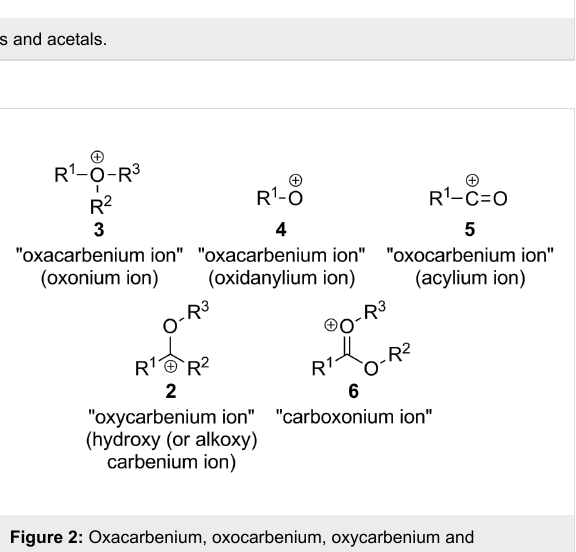
Figure 2: Oxacarbenium, oxocarbenium, oxycarbenium and carboxonium ions.